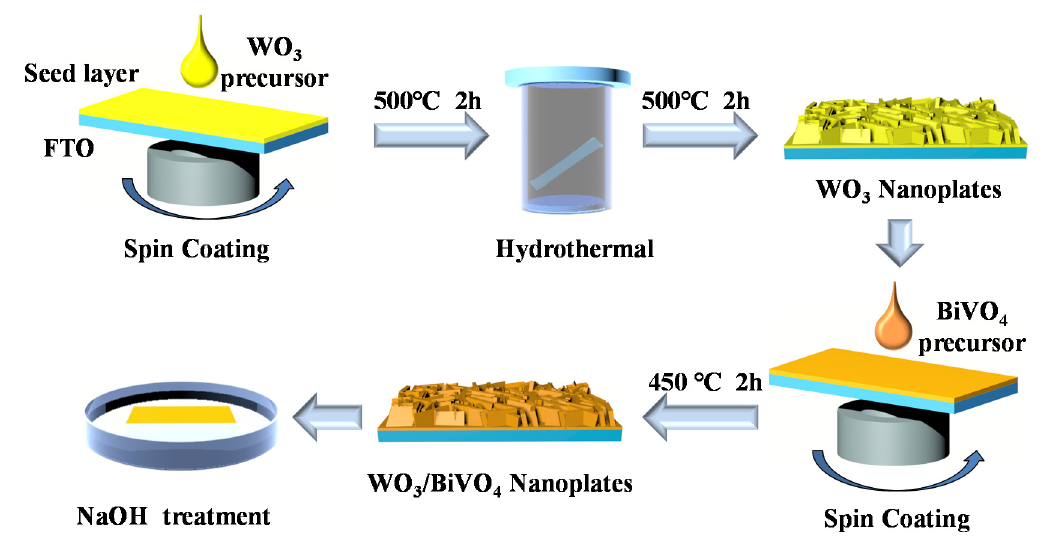
Figure 1. Schematic diagram of the fabrication and post-modification processes of WO 3 / BiVO 4 photoanodes.